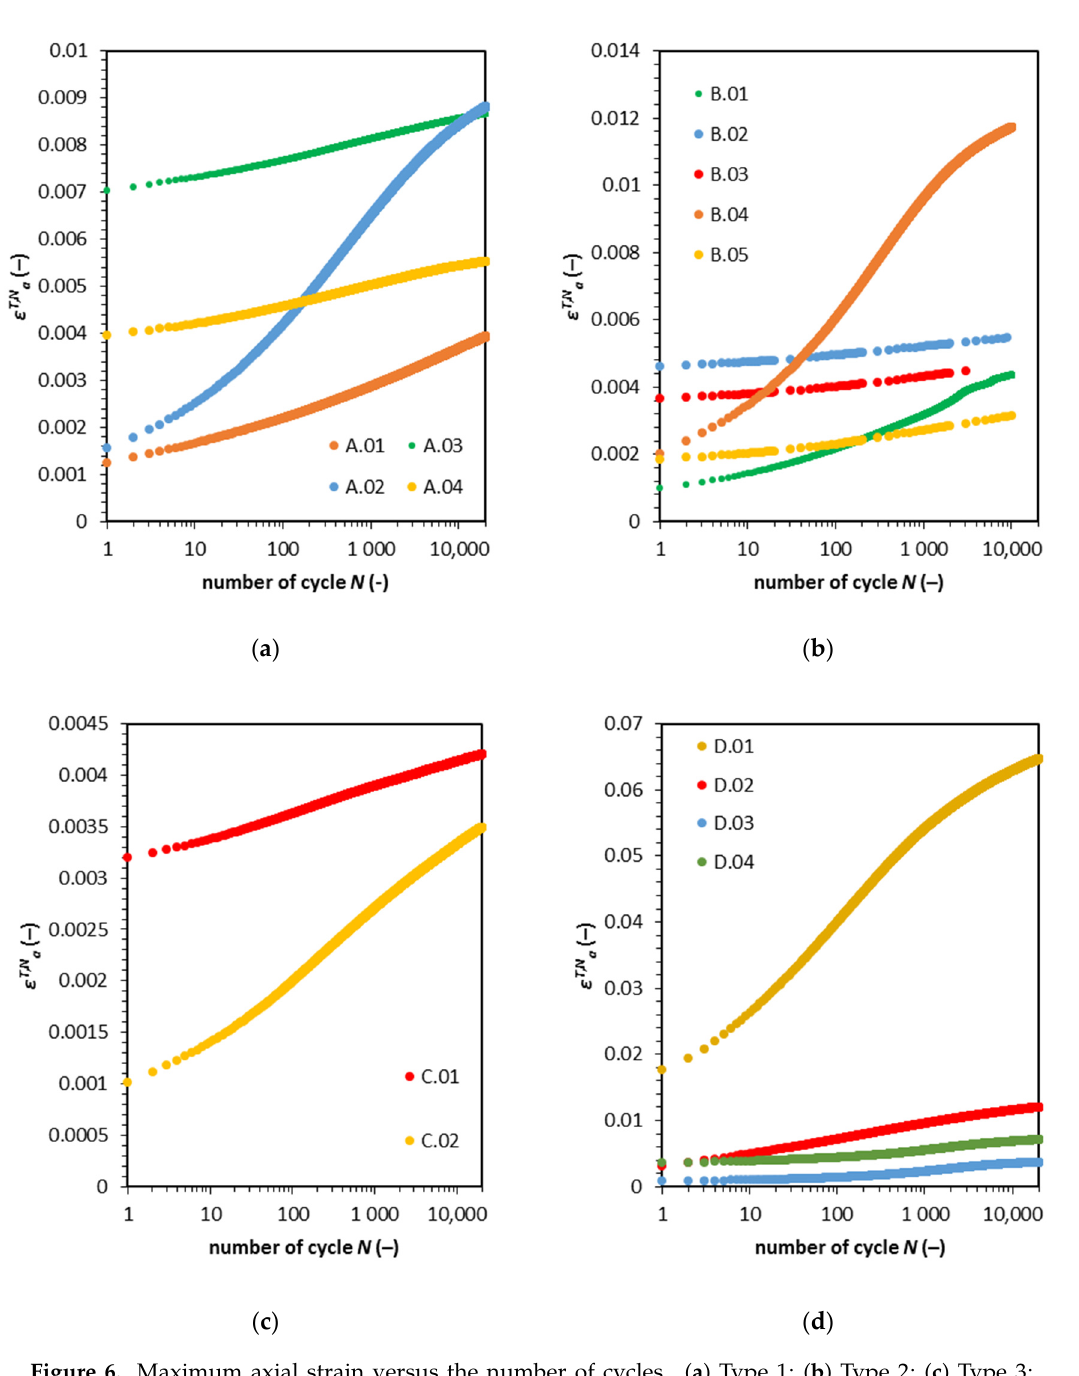
Figure 6. Maximum axial strain versus the number of cycles. ( a ) Type 1; ( b ) Type 2; ( c ) Type 3; ( d ) Type 4.